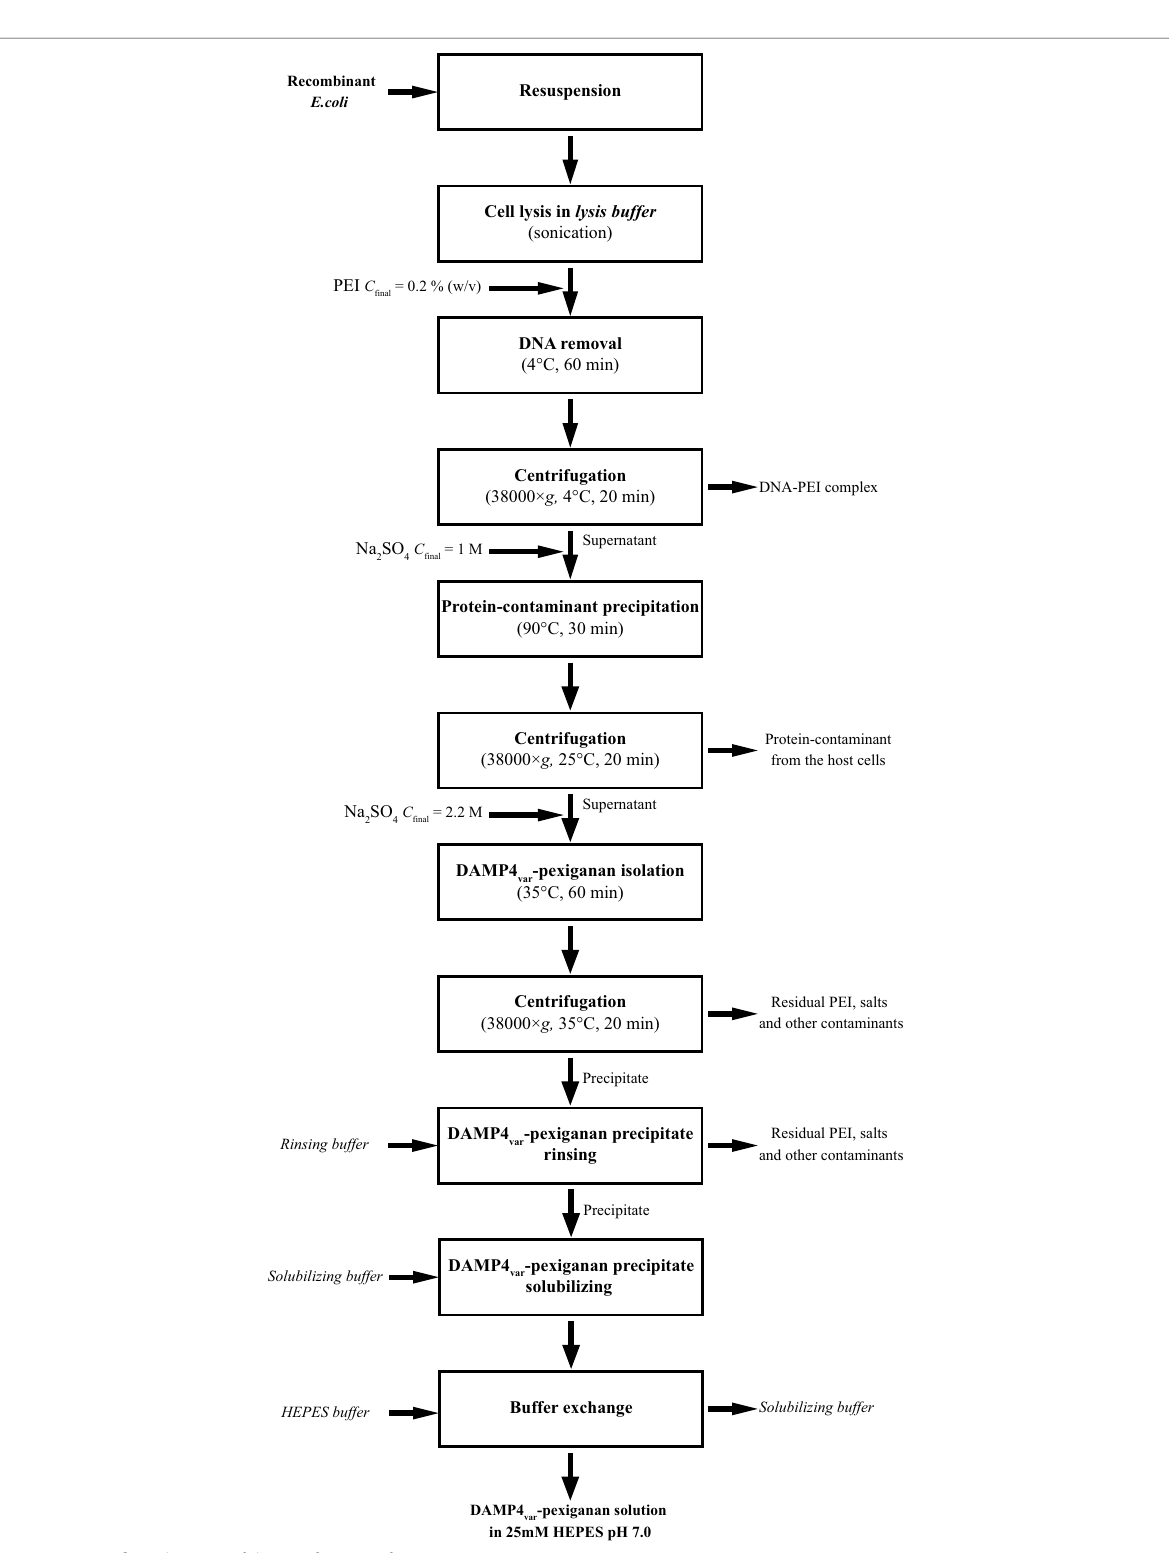
Fig. 9 Process flow diagram of the purification of DAMP4 var ‑pexiganan